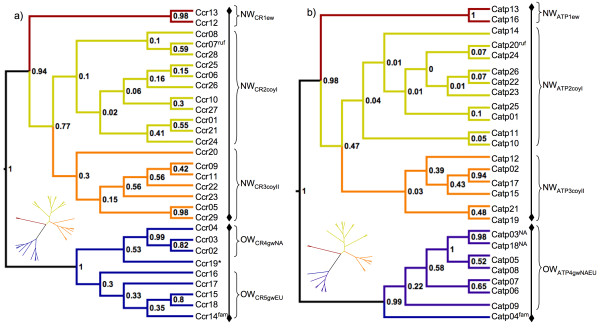
Cladograms of Canis mtDNA CR and ATPase sequences. Cladograms of Canis sequences from Bayesian analysis in BEAST of a) 347 bp of the mitochondrial DNA (mtDNA) control region and b) 1067 bp from the mtDNA ATPase region. fam is a Husky dog sample from Sweden; * is a wolf from Saudi Arabia; ruf is the red wolf sequence, NW represents New World evolved clades, OW represents Old World evolved clades, NA in b) identifies North American grey wolf samples. Node labels show posterior probabilities rounded to the nearest hundredth. For each genetic region the eastern wolf clade is shown in red (NWCR1ew & NWATP1ew), coyote clades I and II are shown in yellow (NWCR2coyI, NWATP2coyI) and orange (NWCR3coyII and NWATP3coyII), and Old World (OW) clades from North America (OWCR4gwNA) and Eurasia (OWCR5gwEU, OWATP4gwNAEU) are shown in blue. Insets show radial view of tree.